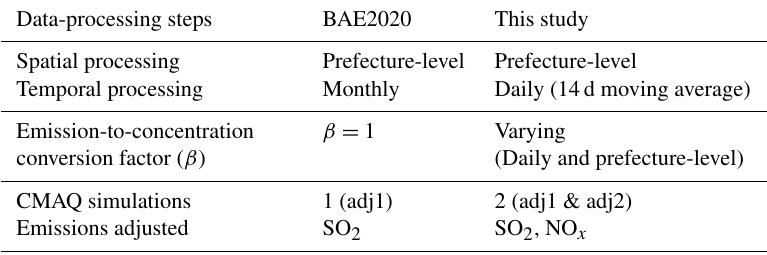
Table 2. Comparison of data-processing steps in the emission adjustment methods used in BAE2020 and this study. Data-processing steps BAE2020 This